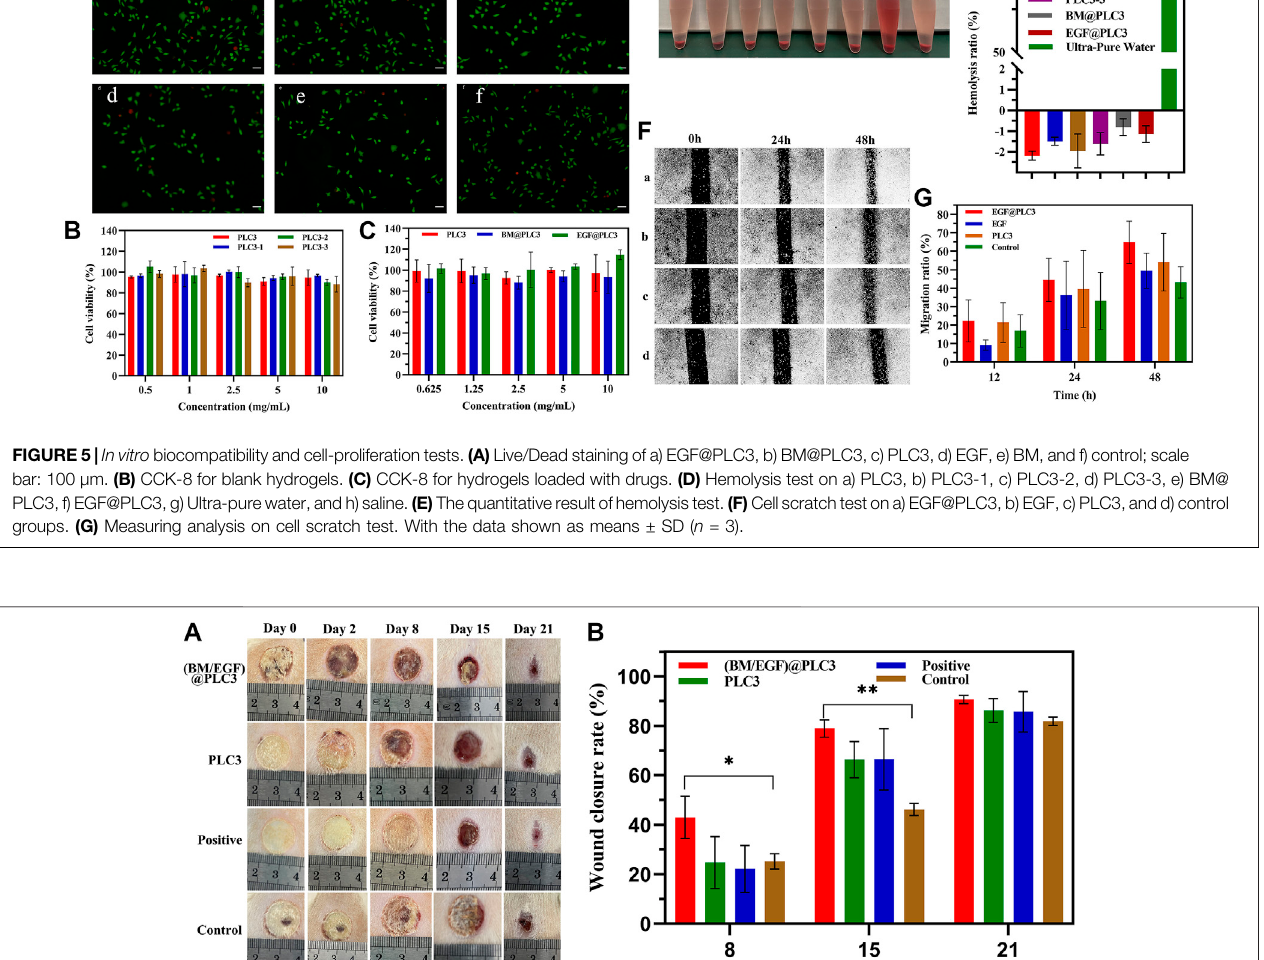
Frontiers in Bioengineering and Biotechnology |